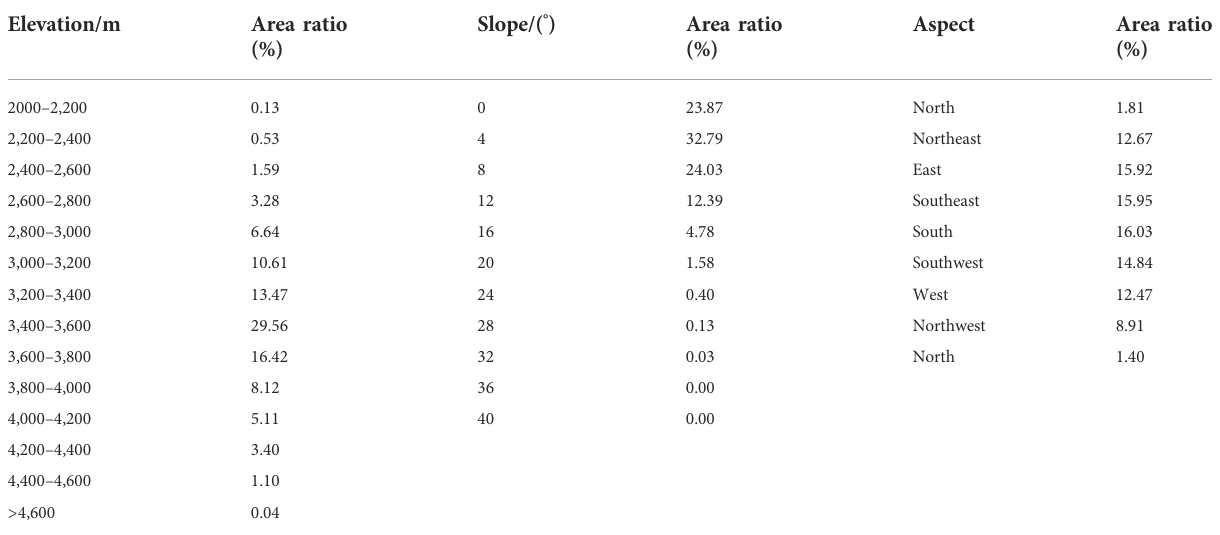
TABLE 1 Area distribution of various topographical